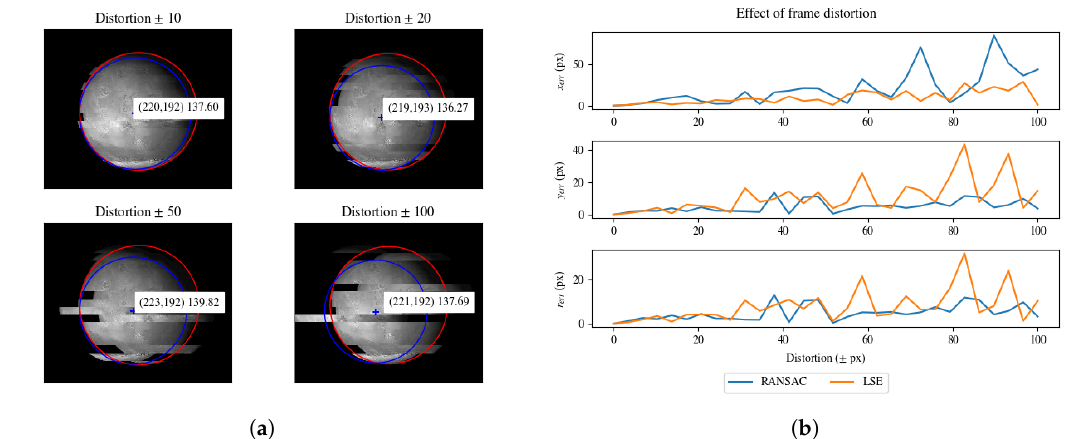
Figure 10. ( a ) Effect on parameter estimation for input image altered by local frame distortion. RANSAC estimation is in red, Least Squares Estimator (LSE) estimation is in blue. ( b ) Estimation errors for model parameters with frame distortion of an increasing amount of